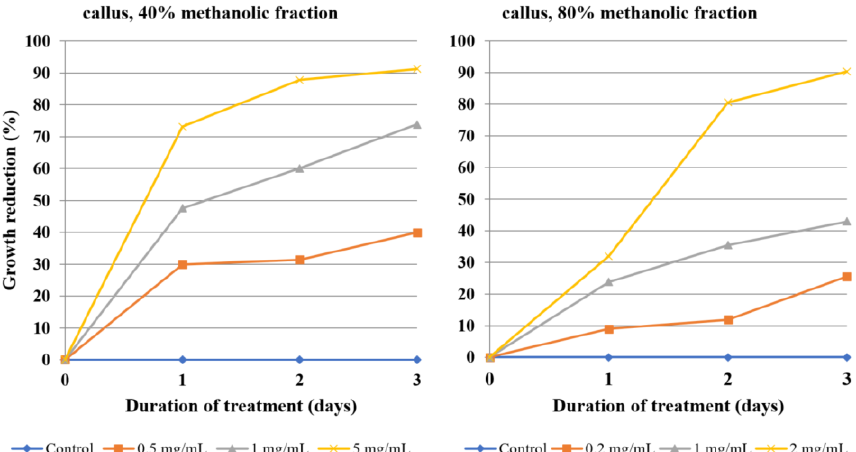
Figure 4. The effect of the 40% and 80% methanolic fractions of extract from the flowering herb of Lychnis flos-cuculi on the inhibition of Acanthamoeba trophozoite proliferation in the culture medi- um.